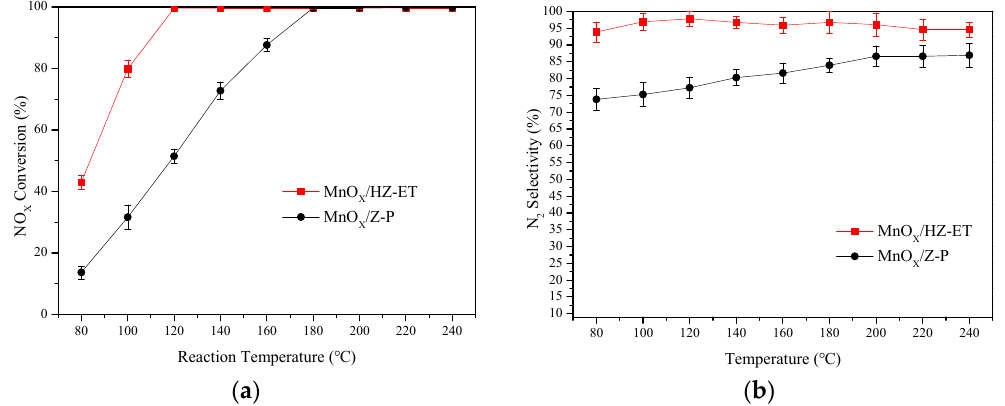
Figure 7. SCR activity ( a ) and N 2 selectivity ( b ) of MnO x /HZ-ET and MnO x /Z-P catalysts with a Mn loading of 15 wt.%.